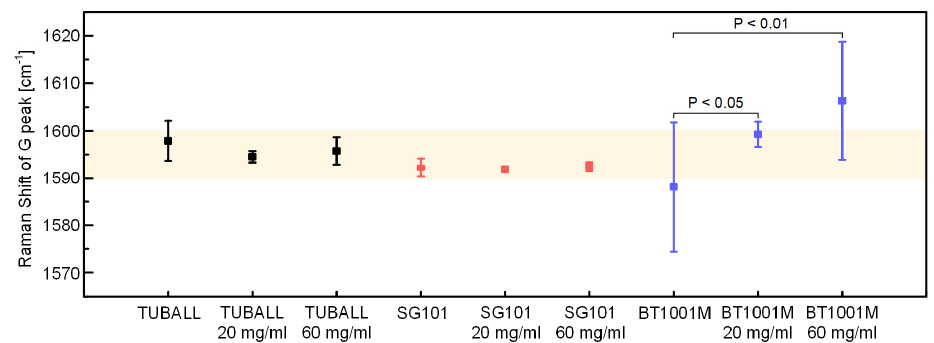
Figure 4. Location of G peaks of each CNT and CNT/ m -cresol. The colored region is the range of 1590−1600 cm −1 .